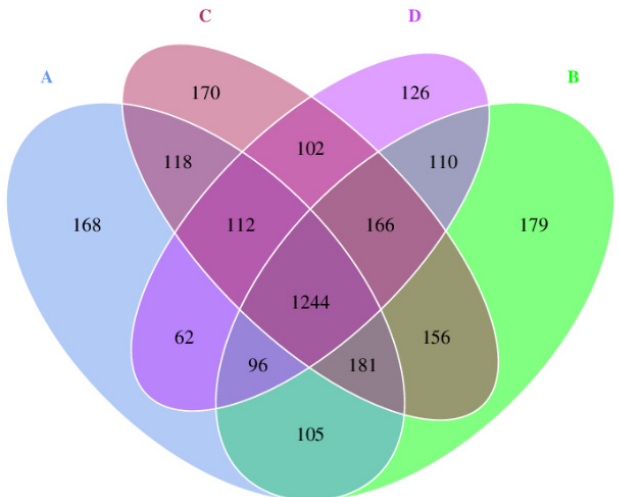
Figure 7. Venn diagram. Each circle represents one sample or group. Values in overlapping parts represent common OTUs. The others are specific OTUs in each sample (A, thermophilic of Harmanli site; B, mesophilic of Harmanli site; C, mesophilic of Yasno pole site; D, thermophilic of Yasno pole site).